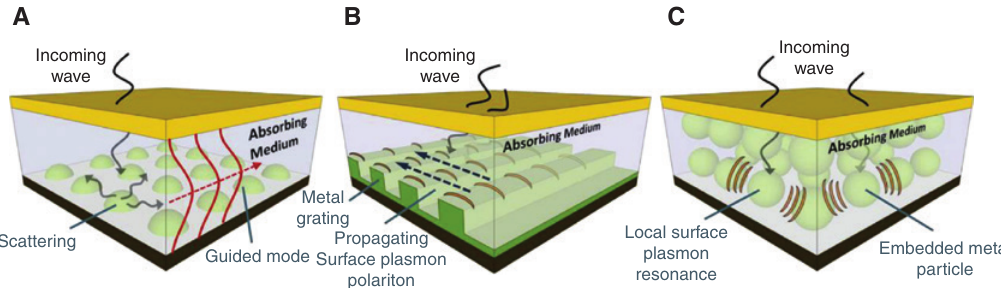
Figure 7: Plasmonic light-trapping mechanism in OPVs based on plasmonic nanostructures. (A) Plasmonic light scattering, (B) SPP effect and (C) LSPR effect (reprint with permission Ref. [101]; Copyright 2011 Materials Research